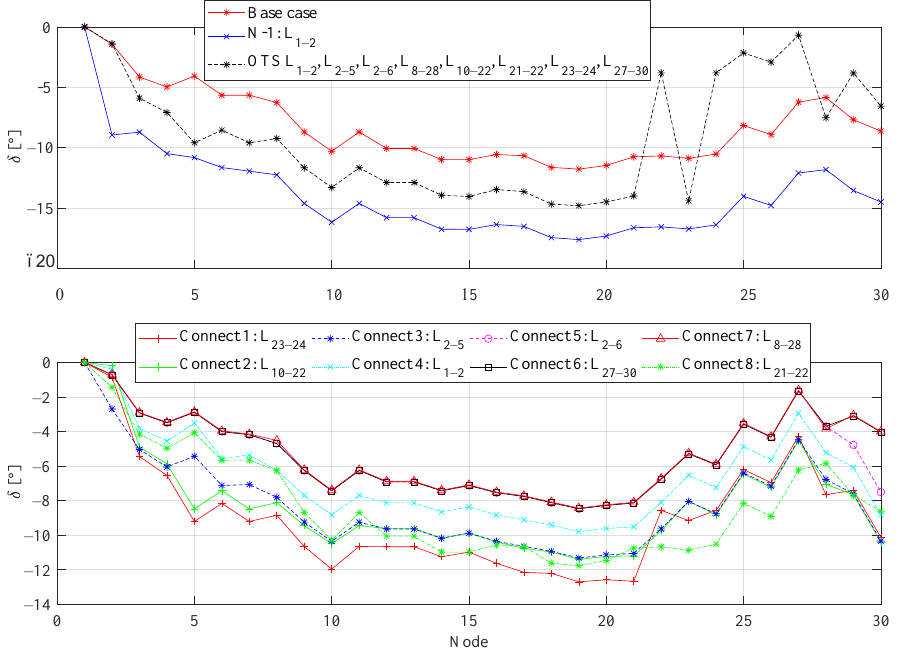
Figure 4. Behavior of the voltage angle δ in the 30 bus bar system. Regarding power flows through the transmission lines in a normal state of the sys- tem, the total demand is satisfied, when changing the topology of the system when the contingency of the L 1 − 2 occurs, it is evident that power flows are redistributed without affecting demand when the OTS is executed, and lines are disconnected, which improves the system response, power flows are redistributed, and load capacity is reduced on some of the lines, to name a few, L 1 − 3 , 32%, L 3 − 4 , 33%, see Figure 5; likewise, the load-ability in other lines of the system is increased. By seeking a connection order for the disconnected lines, the condition of the system is improved and the power flows are redistributed in a